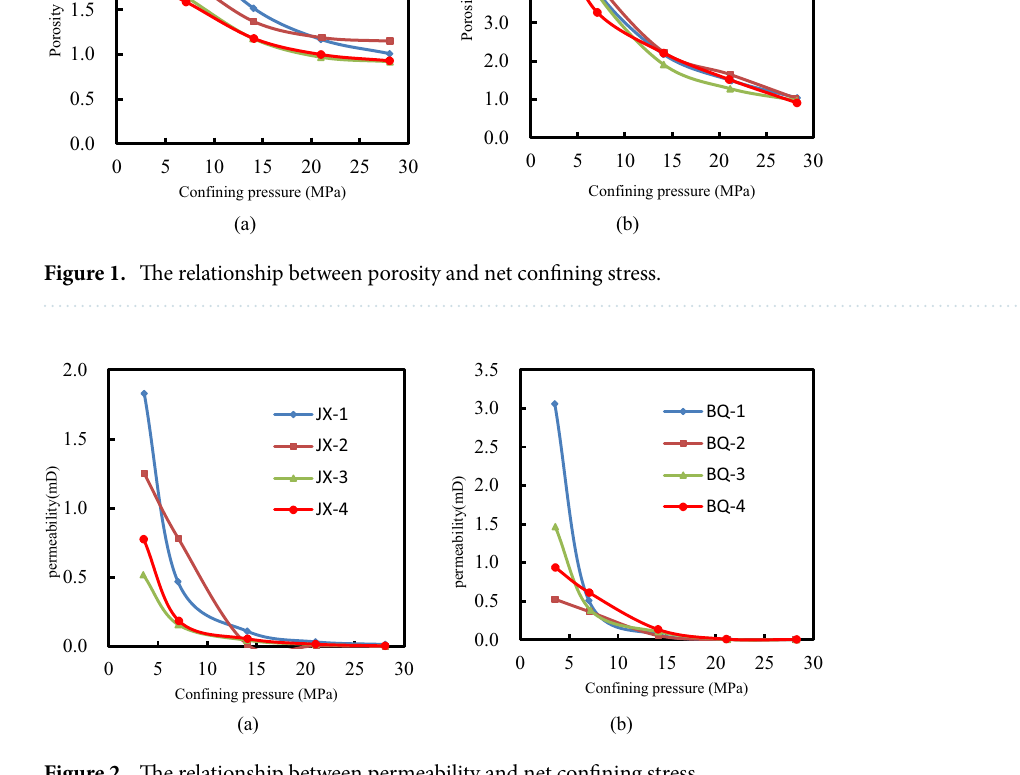
Figure 2. The relationship between permeability and net confining